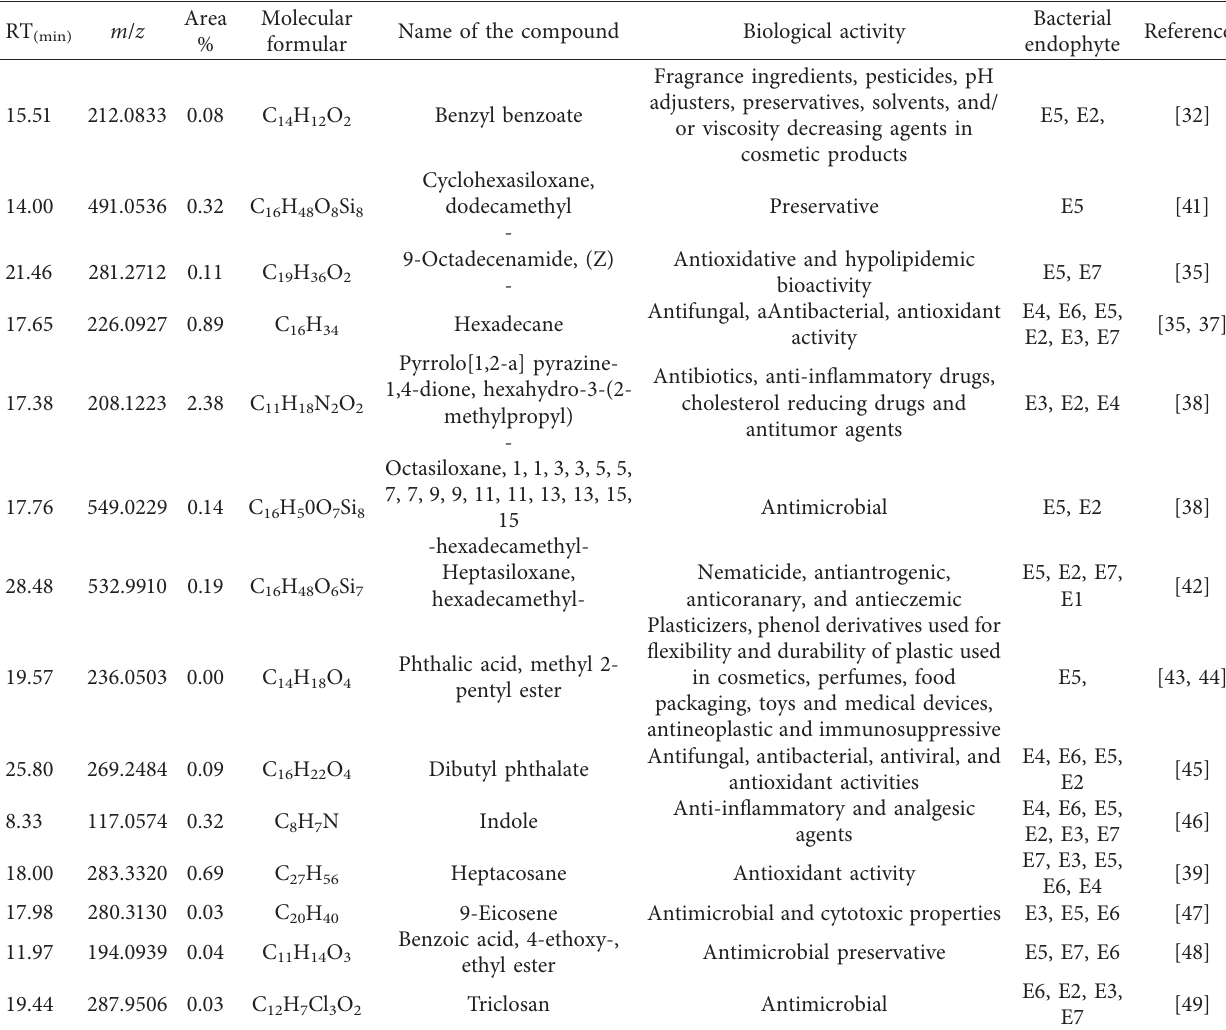
Table 4: GC-HRTOFMS analysis bacterial endophyte’s crude extracts associated with Dicoma anomala . RT (min) m / z